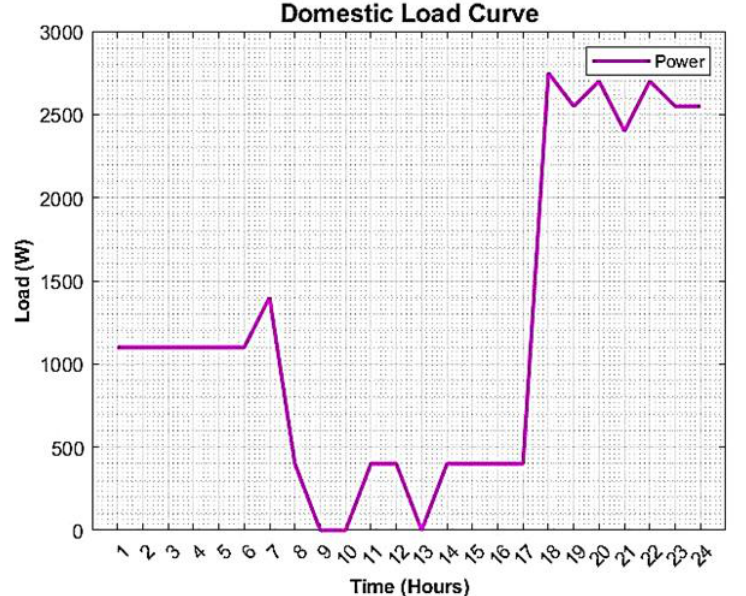
Figure 14. Operation of domestic load